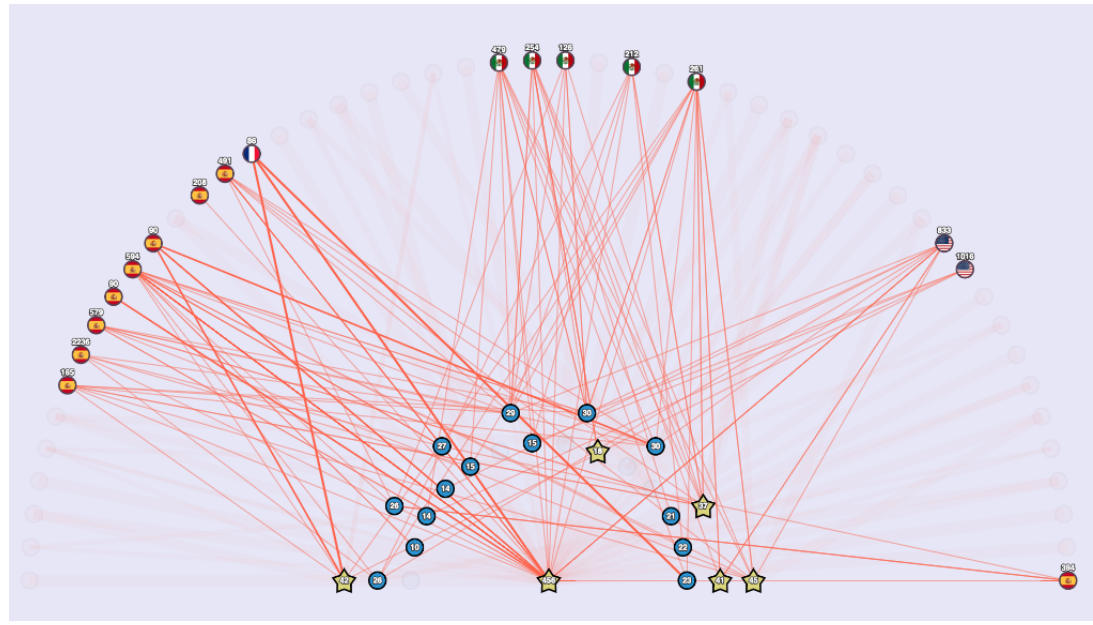
Figure 10. Result of running a query. Only the complying nodes are